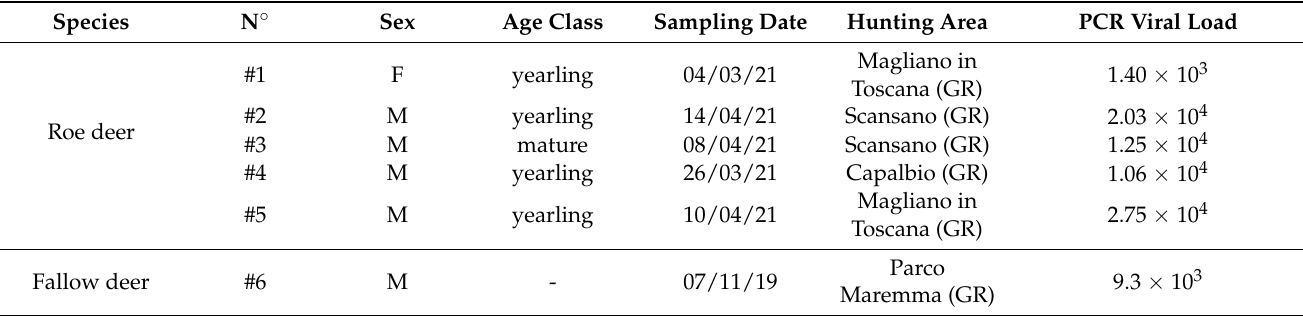
Table 3. Sex, age class, date of sampling, hunting area, and viral load (viral copies/100ng of RNA) of PCR-positive